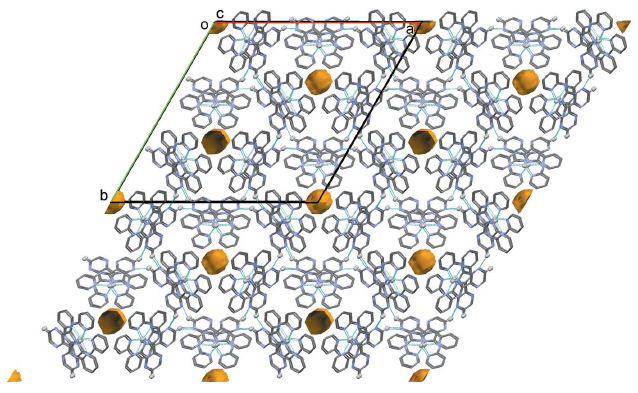
Figure 3 A view along the c axis of the crystal packing of the title compound. The hydrogen bonds are shown as dashed lines (see Table 1) and only H atoms H5 N and H2 have been included (grey balls). The small cavities ( ca 1.1% of the unit-cell volume) are represented in brown/yellow ( Mercury ; Macrae et al. , 2008).